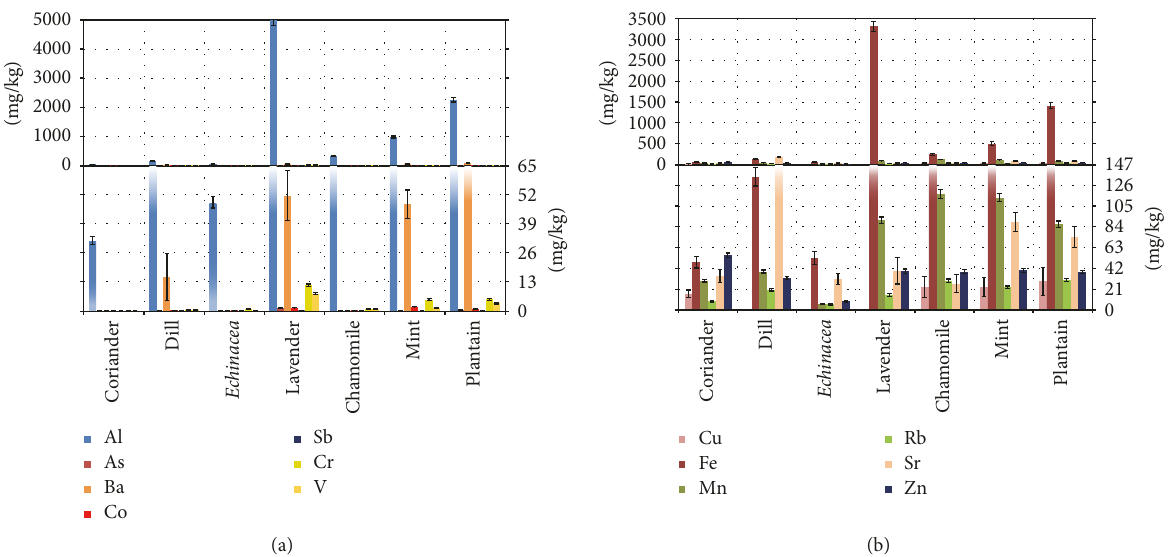
Figure 2: Diagrams of trace and ultra-trace (micronutrient) element concentrations for the seven plant samples; each element is represented in two concentration ranges: a higher one (left vertical axis and upper part of the chart) and a lower one (right vertical axis and lower part of the chart; the gradient fill suggests that the values are higher than the upper limit of this range): (a) elements with toxic or potentially toxic effects and (b) other